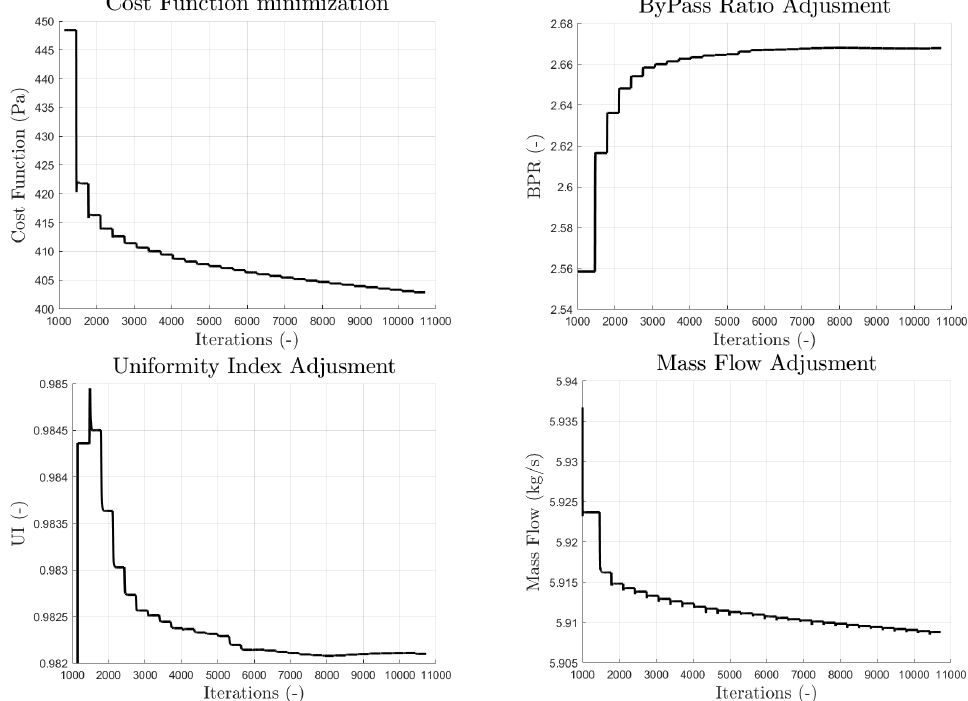
Figure 12. Cost function